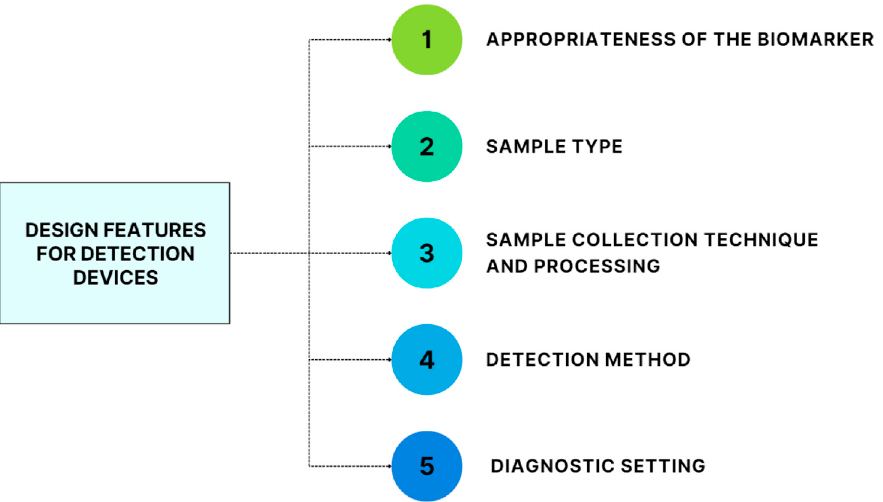
Figure 2. Design features to consider when developing mTBI detecting devices or laboratory tests.